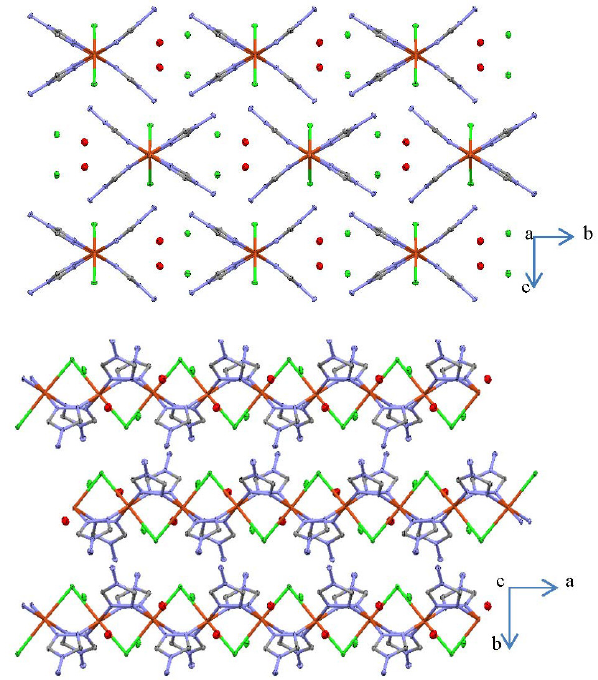
Figure 3. Thermal ellipsoid (50%) plot of III along the a ( top ) and c axes ( bottom ). The nitrogen atoms are depicted in blue, the carbon atoms in grey, the chloride ions in green and the copper atoms in red. H-atoms were omitted for